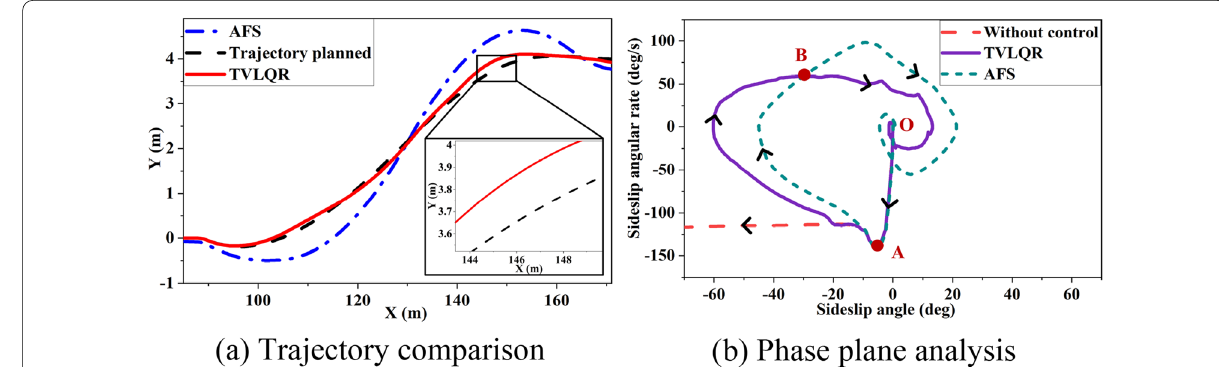
Figure 11 Performance comparison of different control schemes